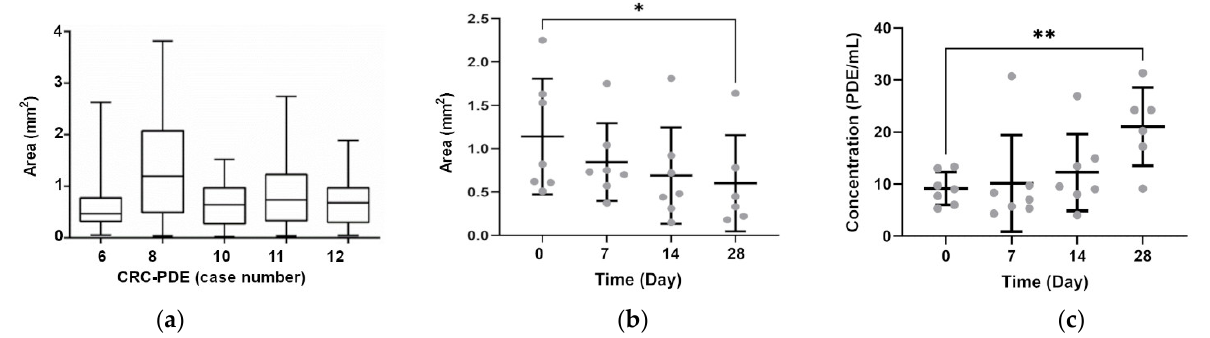
Figure 1. CRC-PDE area and concentration. ( a ) Measurement of CRC-PDE area after tumour sample processing (day 0); box-and-whisker plot shows the median (middle lines), interquartile range (boxes) and minimum to maximum values (whiskers); data were calculated from measurements of at least 15 explants. ( b ) CRC-PDE area and ( c ) CRC-PDE concentration, along 4 weeks of culture; data are presented as mean ± SD, calculated from at least seven biological replicates; statistical significance was evaluated by a mixed effects model for analysis of repeated measurements followed by post-hoc Dunnett’s test comparing with day 0; * p < 0.05, ** p < 0.01. CRC-PDE, colorectal cancer patient-derived explants.